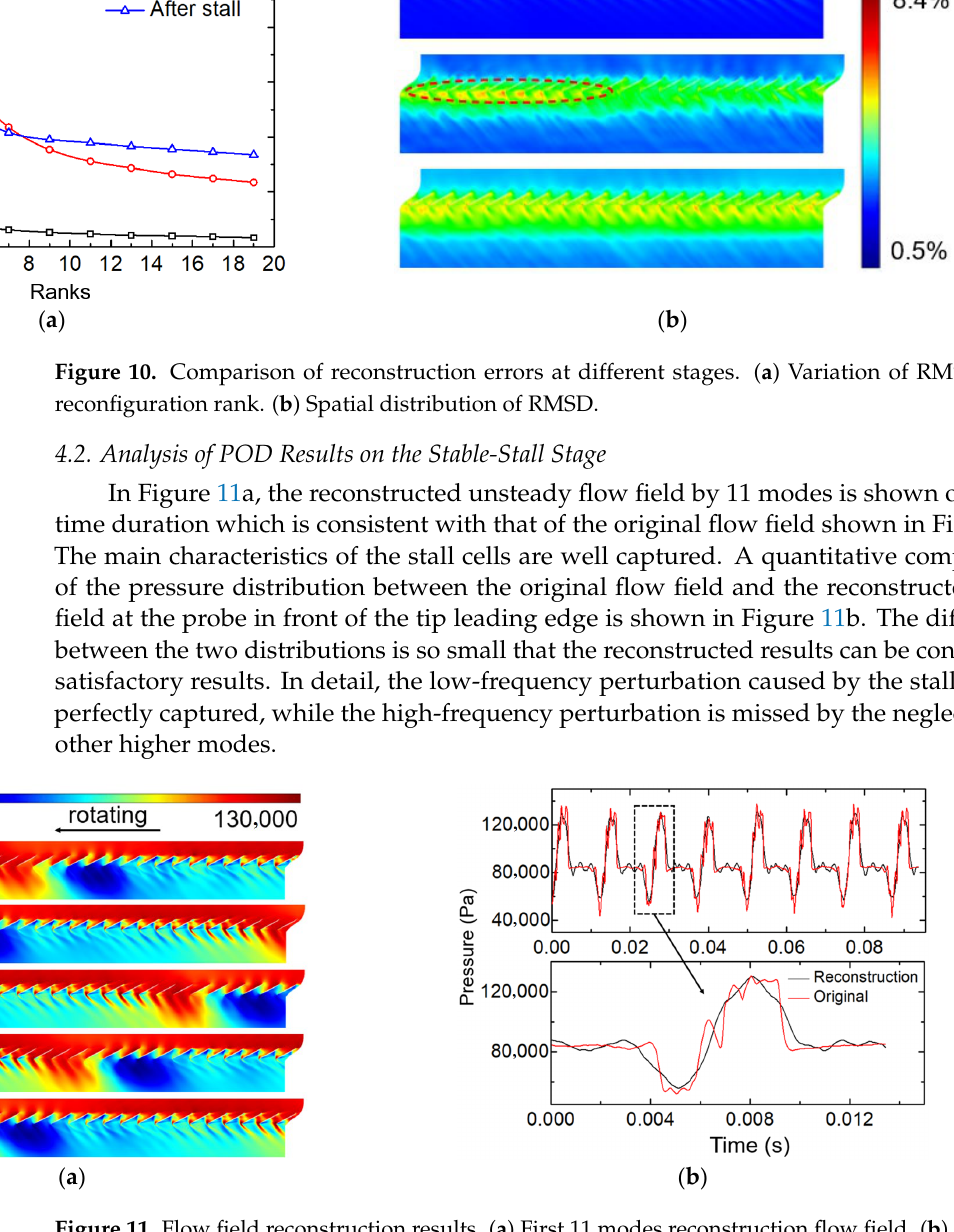
( b ) Figure 12. Flow field reconstruction results. ( a ) Logarithmic eigenvalue. ( b ) Eigenvalue except Mode 1. In Figure 13, the mode and the mode coefficient of the first five modes calculated by Equations (4) and (5) are presented. The horizontal axis of Figure 13b is the time step same as the axis of Figure 11b. From the mode contours, it can be recognized that mode 1, mode 2–3, and mode 4–5 are the mean flow mode, the SRF mode, and the harmonic mode of the SRF mode, respectively. It is found the description of the stall cell structure in the flow field by the POD mode is similar to that by the Fourier transform, by which a series of